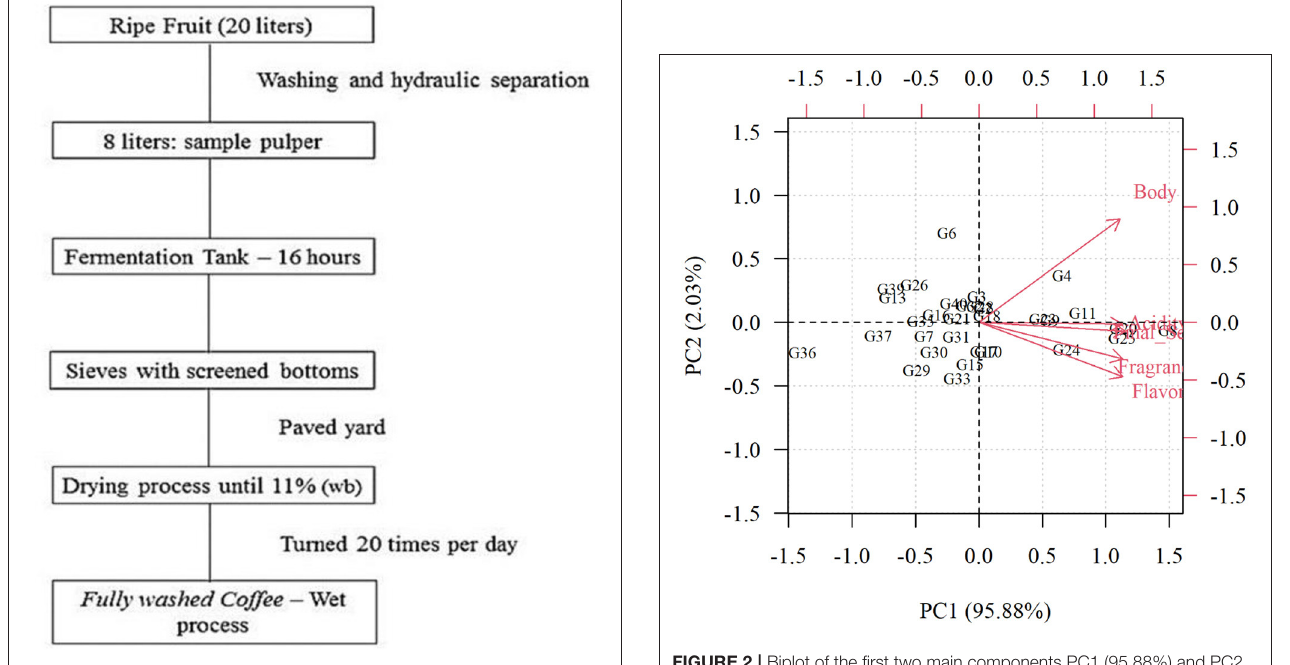
FIGURE 1 | Flowchart of the wet processing method adopted to obtain fully washed coffee.